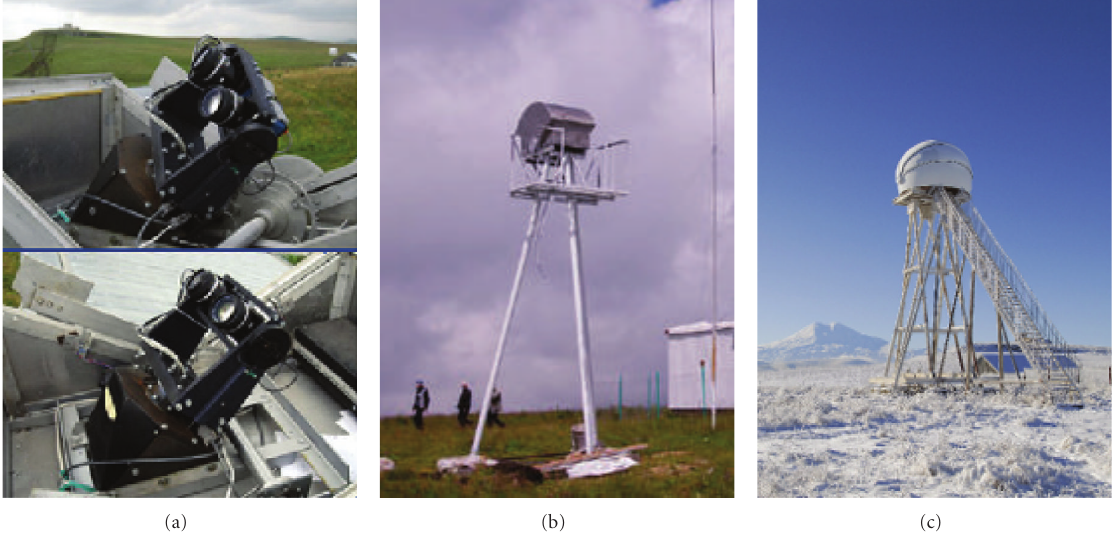
Figure 2: The equipment of the MASTER facility deployed at the MSU Caucasian Mountain Astronomical Observatory near Kislovodsk. From the left to right: (a) the East and West cameras of the MASTER-VWF4 northern installation, (b) the main tower and shelter of the southern MASTER-VWF4 installation, and (c) the main tower of the MASTER-2 telescope